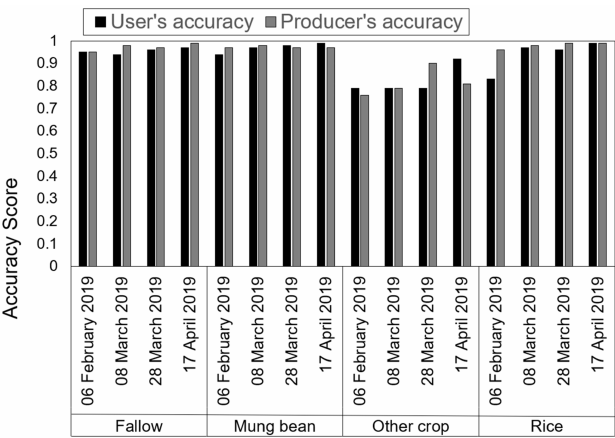
Figure 9. Change of user’s and producer’s accuracies over time for four crop types grown in the Barisal division of Bangladesh in 2019. The accuracies are based on di ff erent sequences of images, starting with one image acquired on February 6 and ending with 4 image acquisition dates by